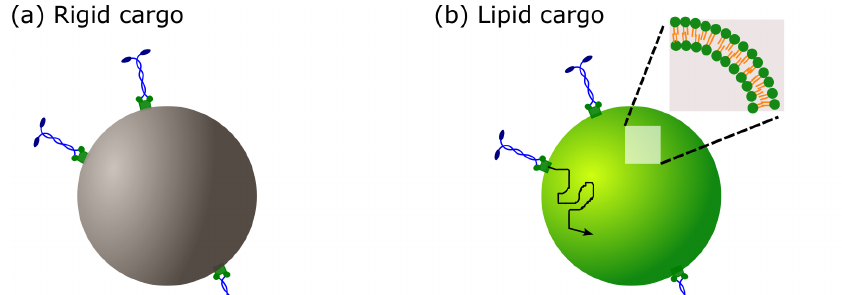
Fig 1. Schematics of cargoes considered in the study. (a) Rigid cargo (membrane-free cargo). Molecular motors are permanently attached to random locations on the cargo surface. (b) Fluid/Lipid cargo (membrane-enclosed cargo). Molecular motors diffuse on the cargo surface. Inset of Fig 1b The lipid bilayer that forms the fluid cargo surface. (c) Schematic that shows how we compute the forces generated by motors. X is the center of mass of the cargo, A i and H i represent motor anchor and motor head positions. Motors exert spring like forces only when their lengths L their rest length L mot . Here, motor 1 experiences a hindering load ( f 1 is negative), while motor 2 experiences an assistive force ( f 2 is positive).